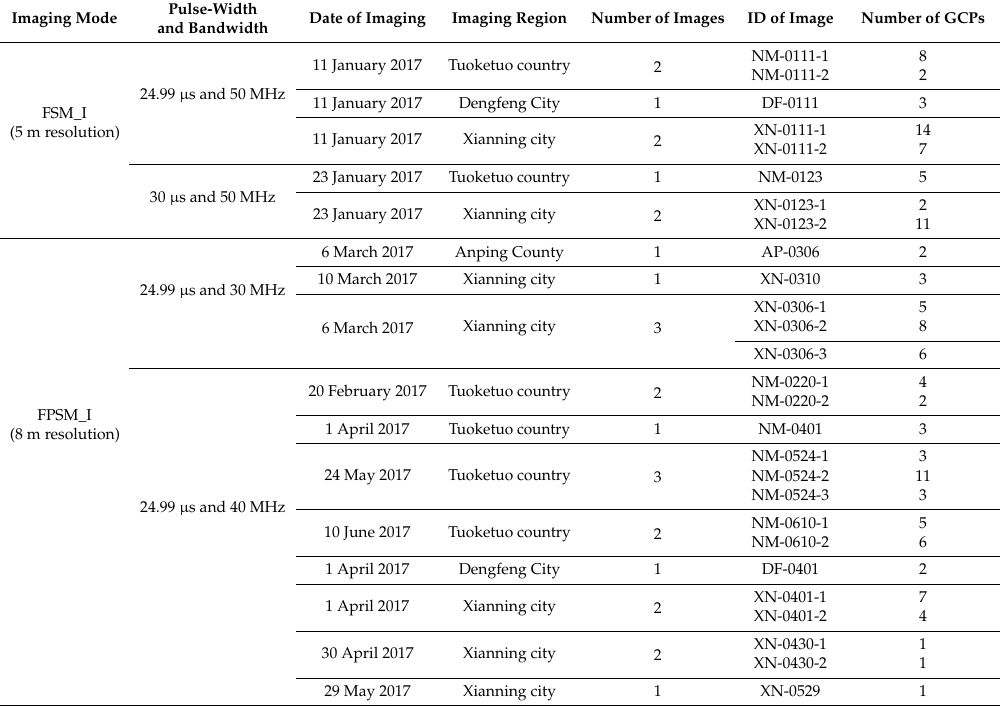
Table 2. GF-3 SAR image data of the study